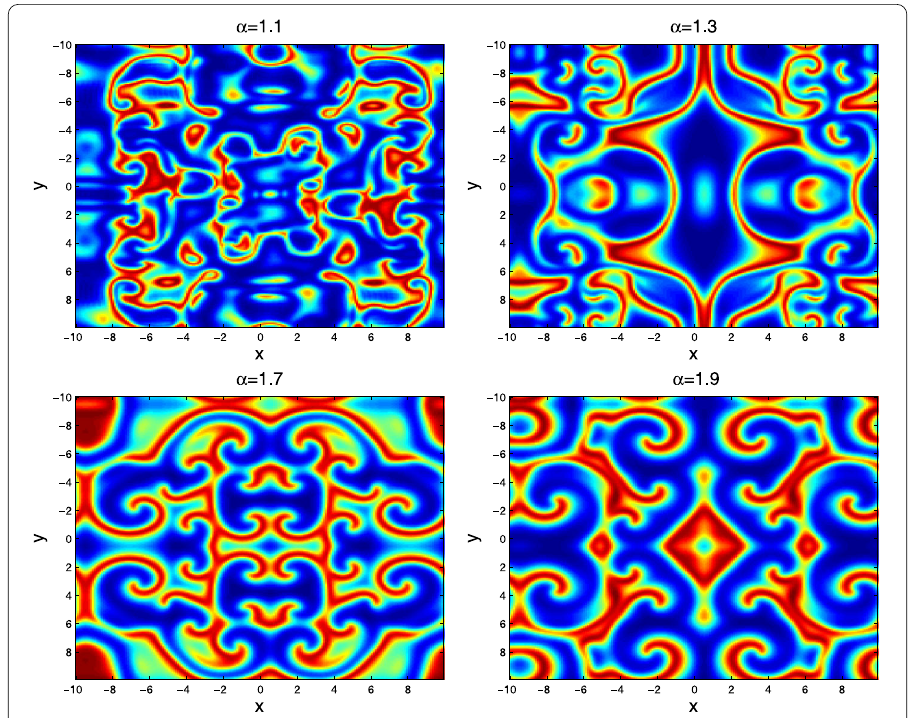
Figure 5 Evolution of spatio-temporal complex spiral patterns of v for kinetics (4.3) at superdiffusive scenarios. Parameter values and initial data as in Figure